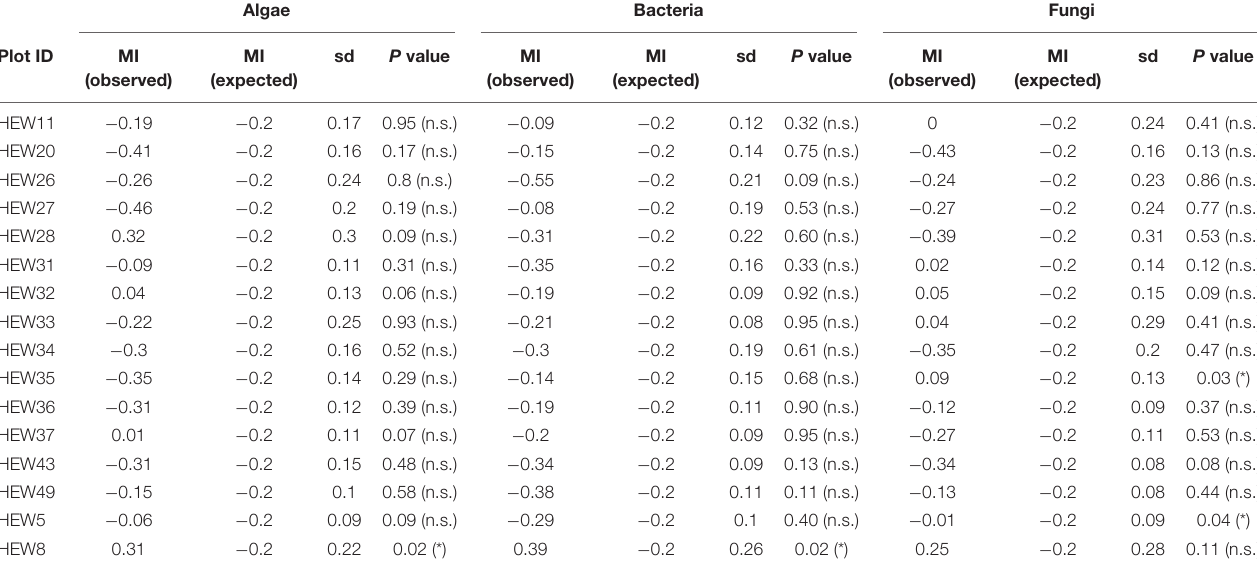
TABLE 2 | Overview of Moran’s I (MI) values for all three organismal groups in the studied plots.